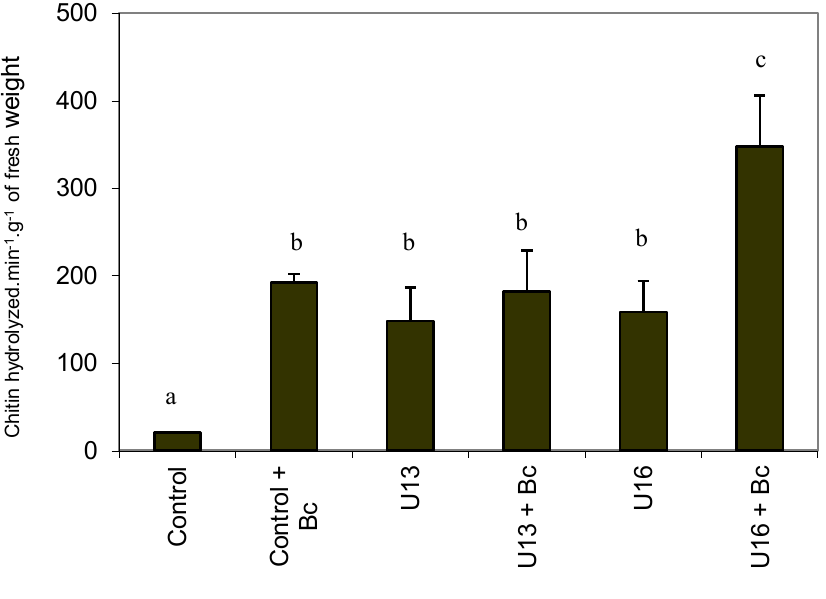
Figure 5. The effect of the presence of antagonist on the induction of chitinase activity in the shoot leaves of grapevine plantlets. Three days before inoculation with the pathogen the leaves were treated with isolate of U13 or U16 or water. The results are expressed as the mean of two separate experiments (in each experiment three different extractions were pooled). Bars with the same letters represent values that are not significantly different according to Fisher’s protected LSD test ( p <